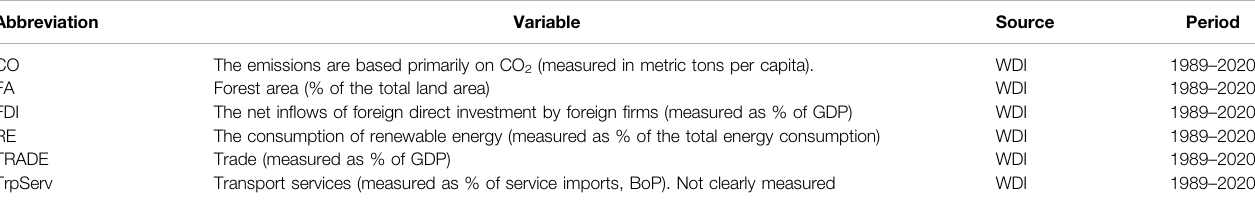
TABLE 1 | Description of variables and the data